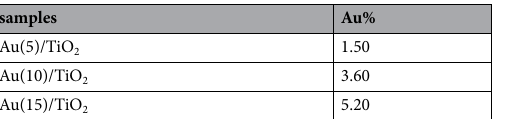
Table 1. The actual Au contents of Au(x)/TiO 2